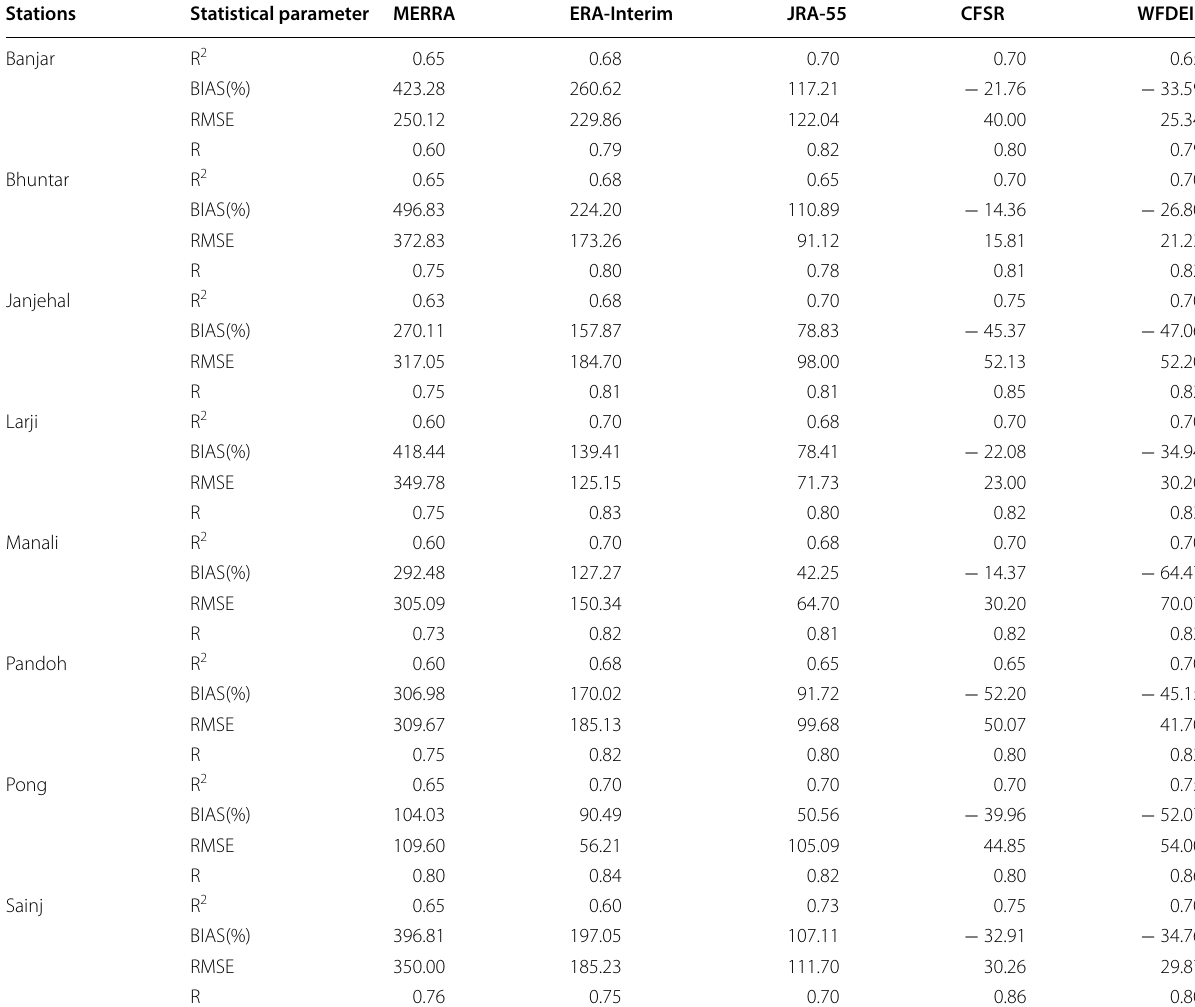
Table 2 Summary of the monthly statistical indicators Stations Statistical parameter